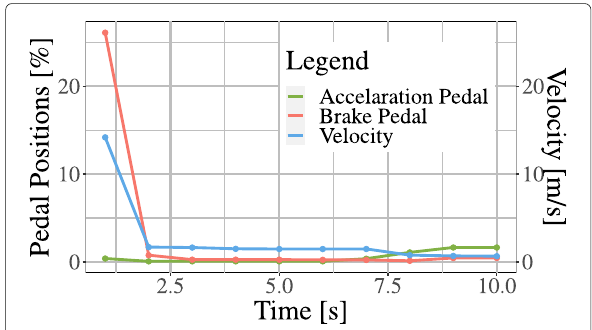
Fig. 16 Manoeuvre 79. Line plot of the variables in the codebook vector of node